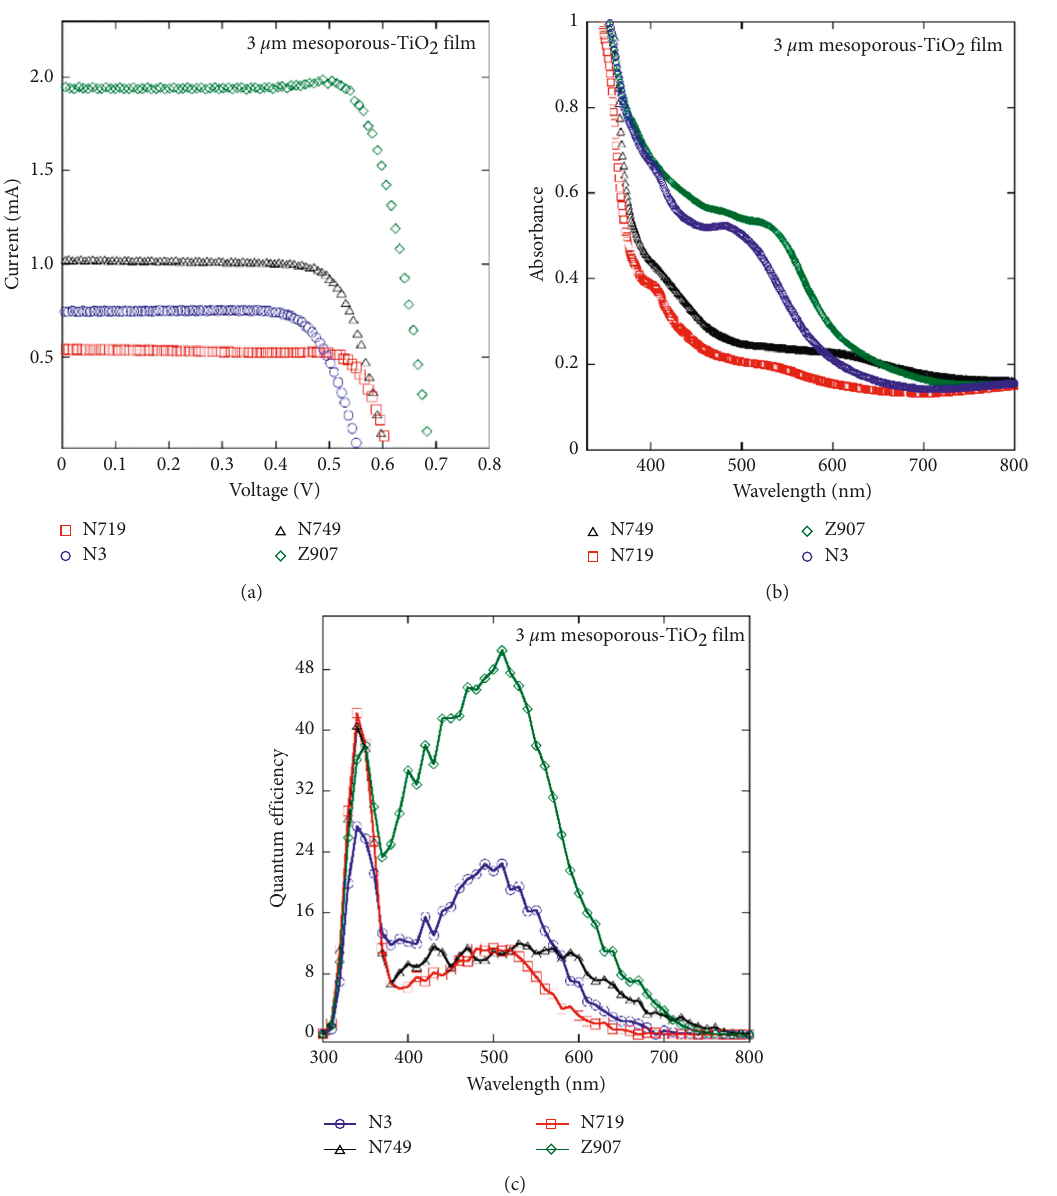
Figure 2: (a) IV and (c) quantum efficiency characteristic curves of devices fabricated with 3 μ m mesoporous TiO ruthenium dyes N3, N749, Z907, and dye N719. (b) Absorbance at dye peaks on solid 3 μ m mesoporous TiO 2 films show correlation with device quantum efficiency of respective dyes. Both device quantum efficiency in (b) and absorbance in (c) of dyes N3 and N749 show intersection at